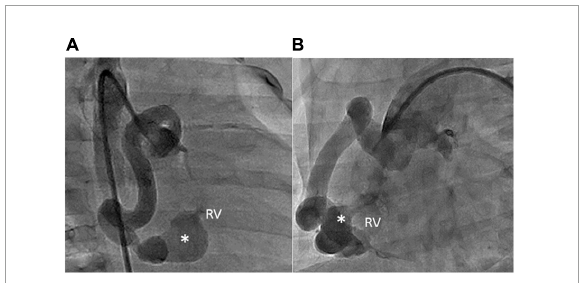
FIGURE3 RCA angiography revealing that the aneurysmal fistula (asterisks) had arisen from the distal RCA and drained into the inferior wall of the RV. The shape of the fistula was lageniform. The aneurysmal tract of the fistula was 6 mm wide. The narrowest diameter of the drainage site was 1.5 mm. (A) RAO 30 ◦ and (B) LAO 60 ◦ .